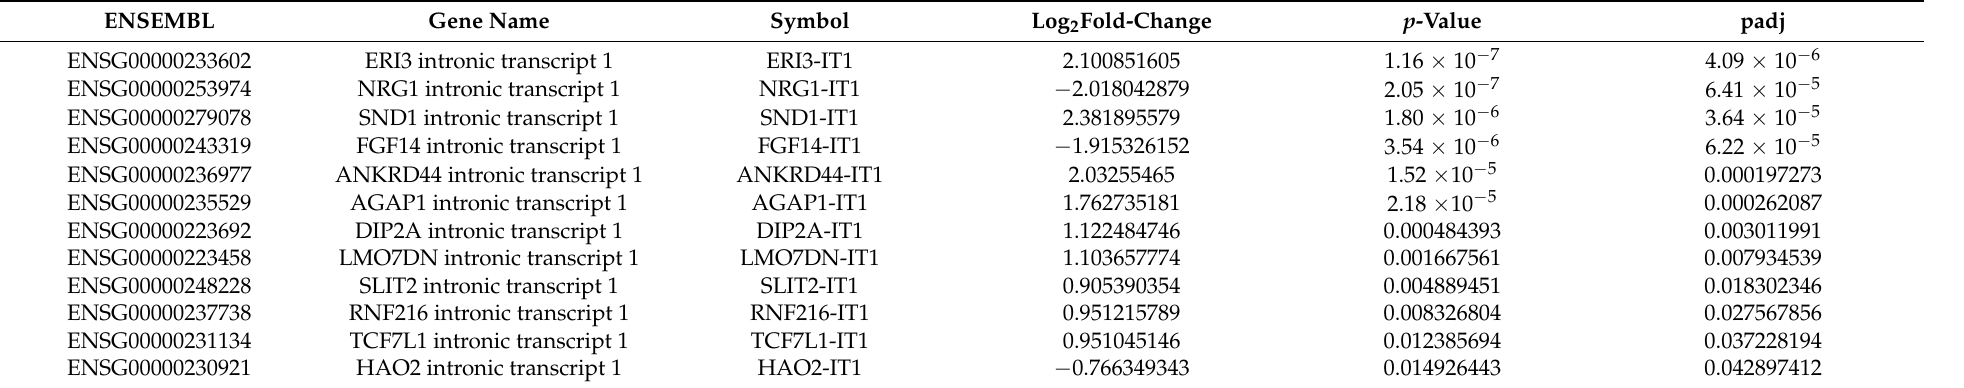
Table 2. The list of differentially expressed intronic transcripts between osteosarcoma tumour and normal bone samples, with their corresponding log 2 FoldChange, p -value, and